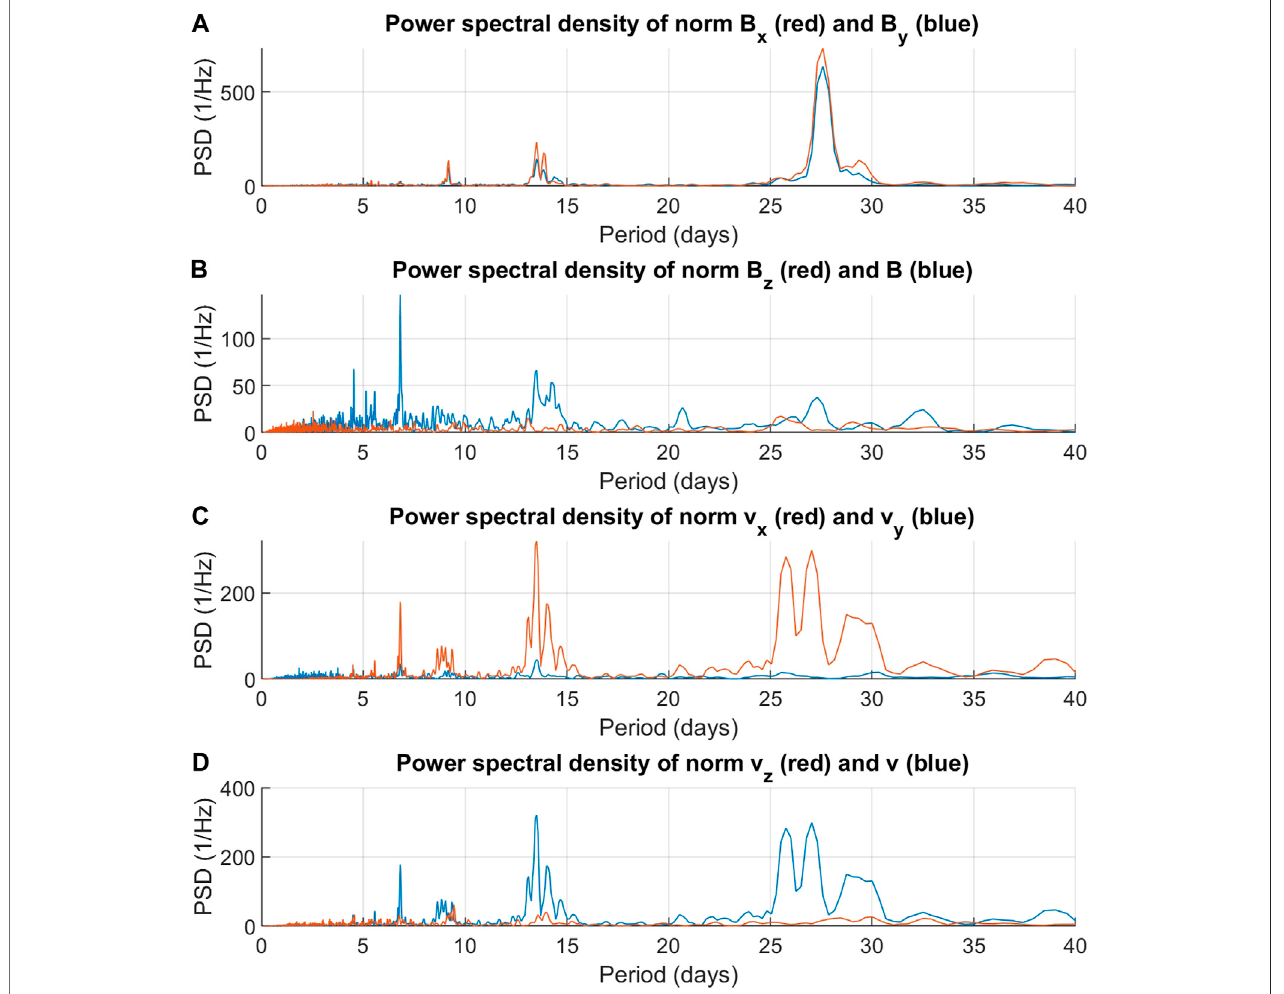
FIGURE 3 | Power spectral densities (PSD) of normalized components of the HMF (A, B) and velocity of SW (C, D) .